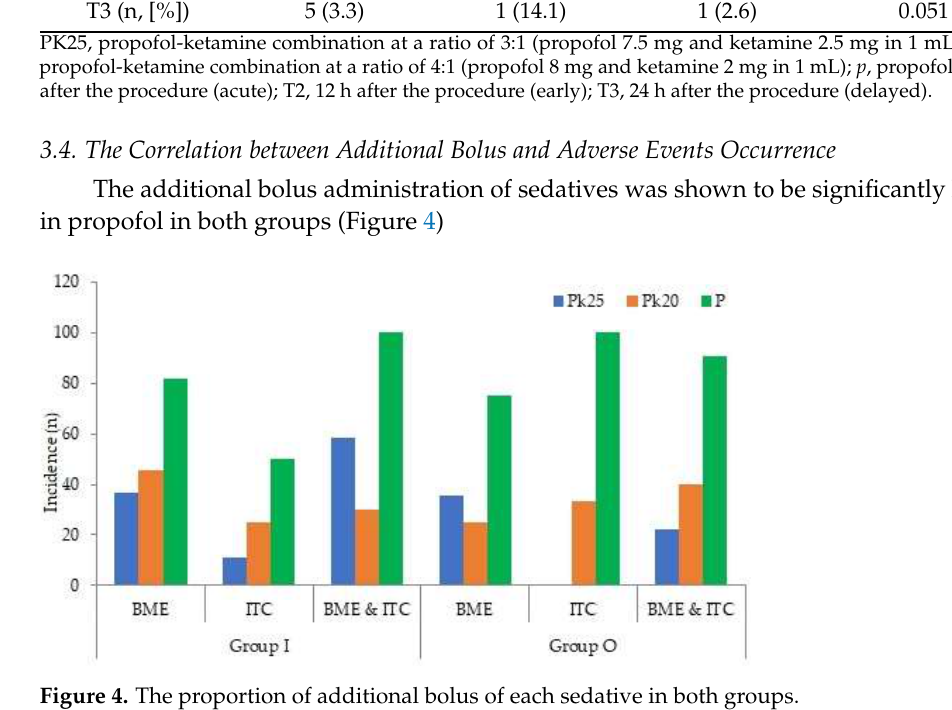
Figure 4. The proportion of additional bolus of each sedative in both groups. However, when we compared the adverse events with additional bolus and without additional bolus in each group, there were no relationships between additional bolus and adverse events (Figure 5).